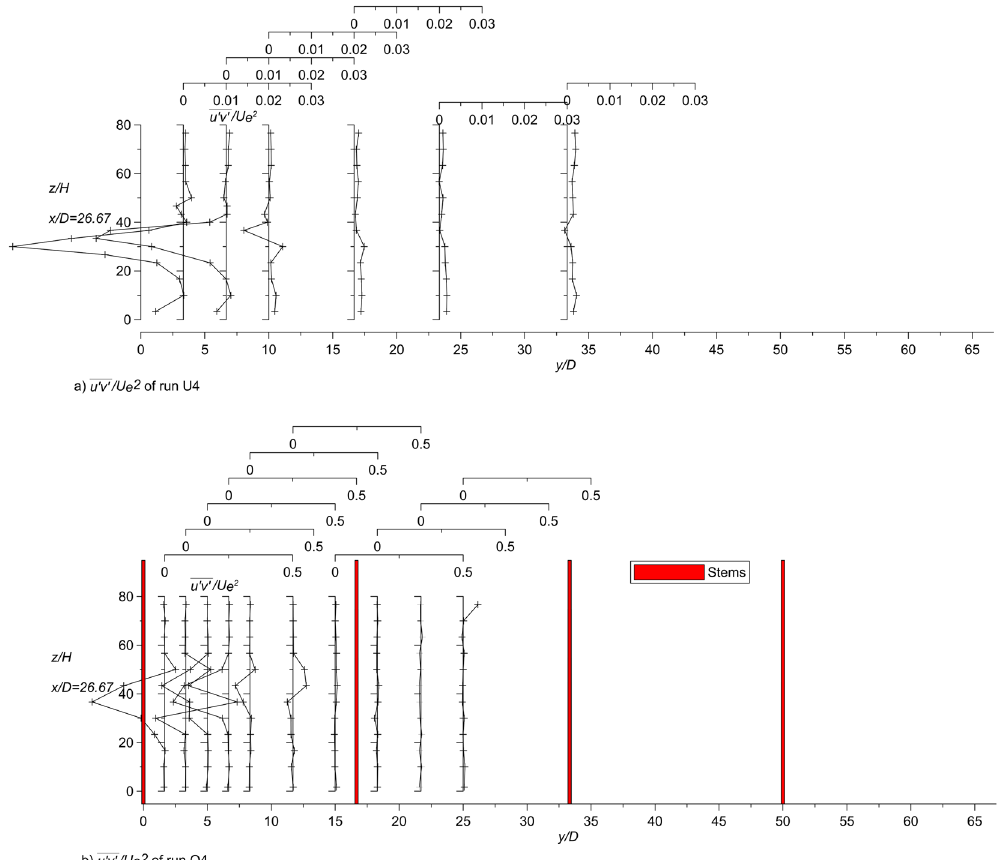
Figure 13. Transversal profiles of the dimensionless time-averaged values of u’v’ of runs U4 and O4.